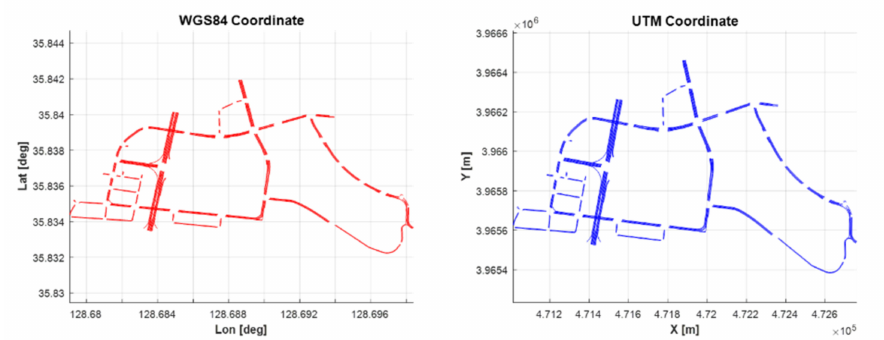
Figure 3. Example of WGS84 to UTM coordinate